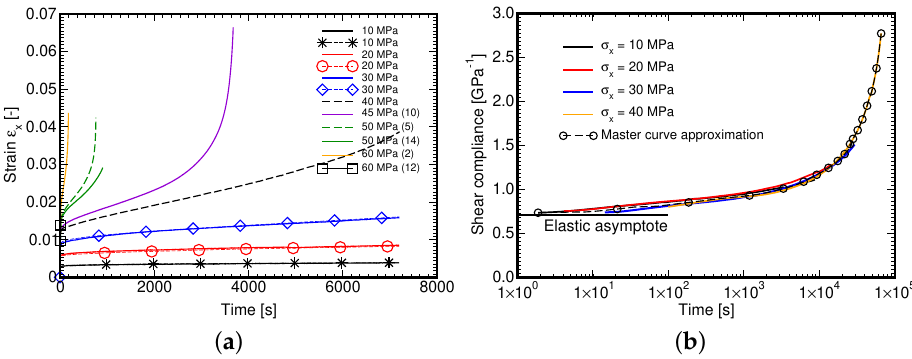
Figure 8. L285/H500: ( a ) Creep experiment, ( b ) Master curve derived from